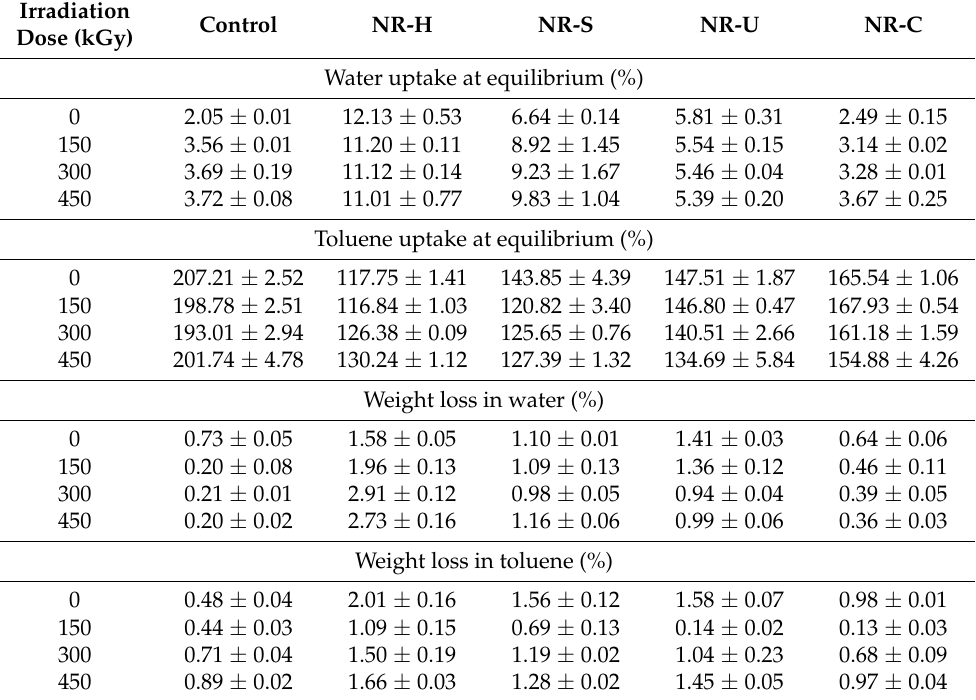
Table 7. The uptake at equilibrium and weight loss in water and